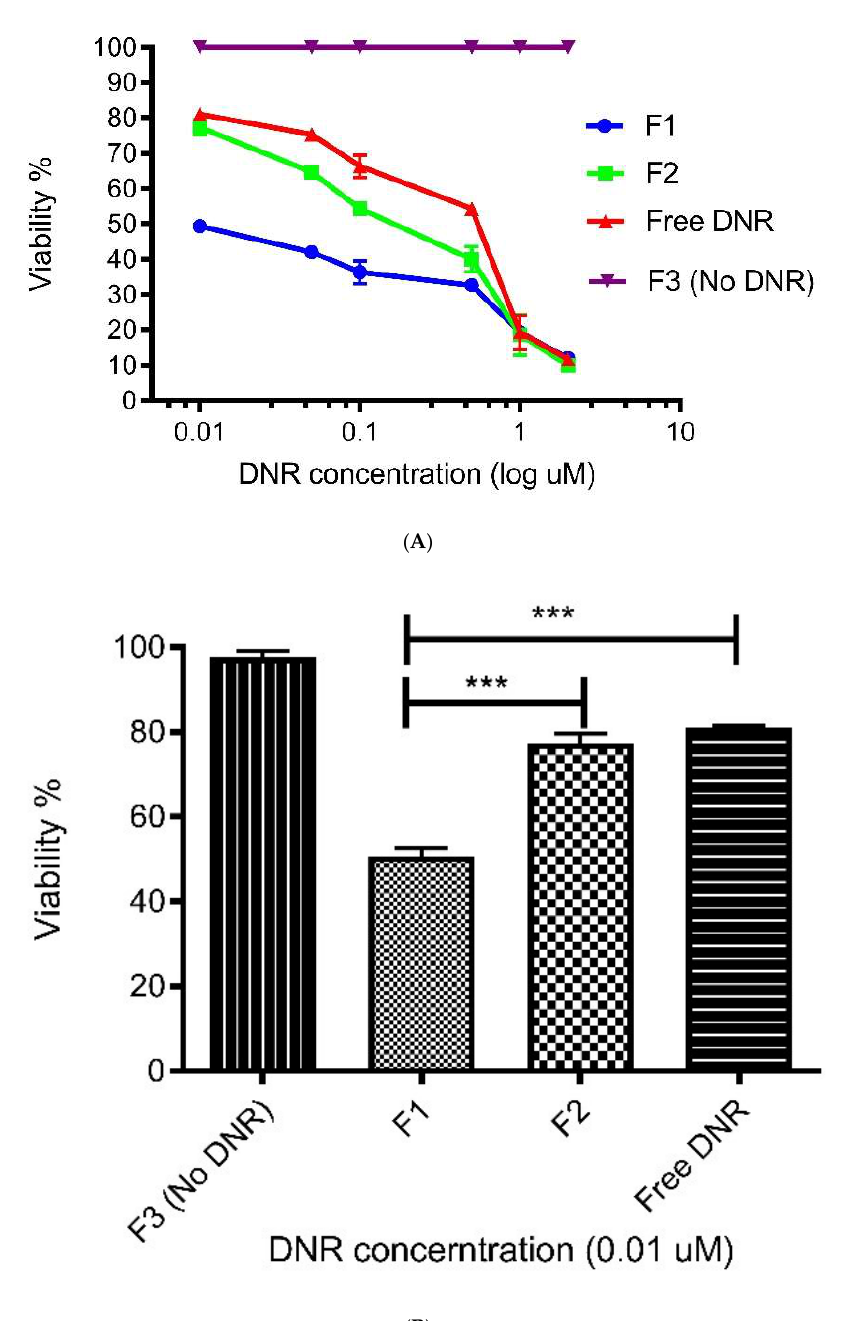
Figure 2. ( A ) CL potentiates the cytotoxic effect of DNR pH-sensitive liposomes against B16-BL6 cell lines. All data are expressed as mean percentages ( n = 3) compared to untreated control cells. ( B ) In vitro cytotoxicity of different formulations in B16-BL6 cell lines. *** indicates p < 0.001. Values represent mean ± SD, n =